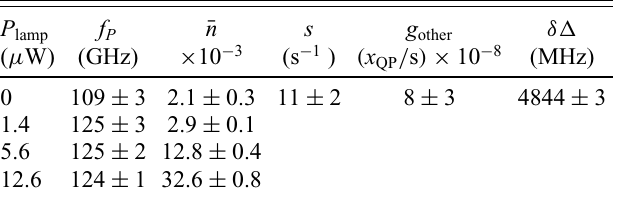
TABLE I. The model parameters corresponding to the fit shown in Fig.